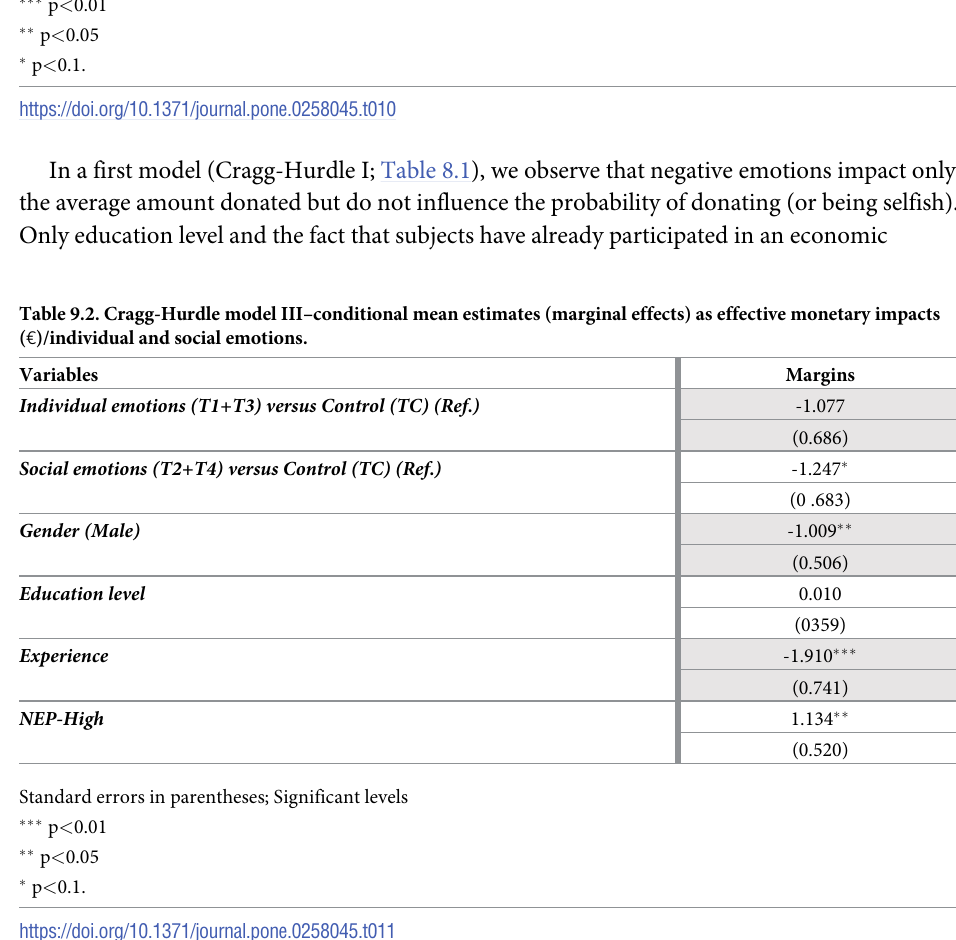
Education level Experience